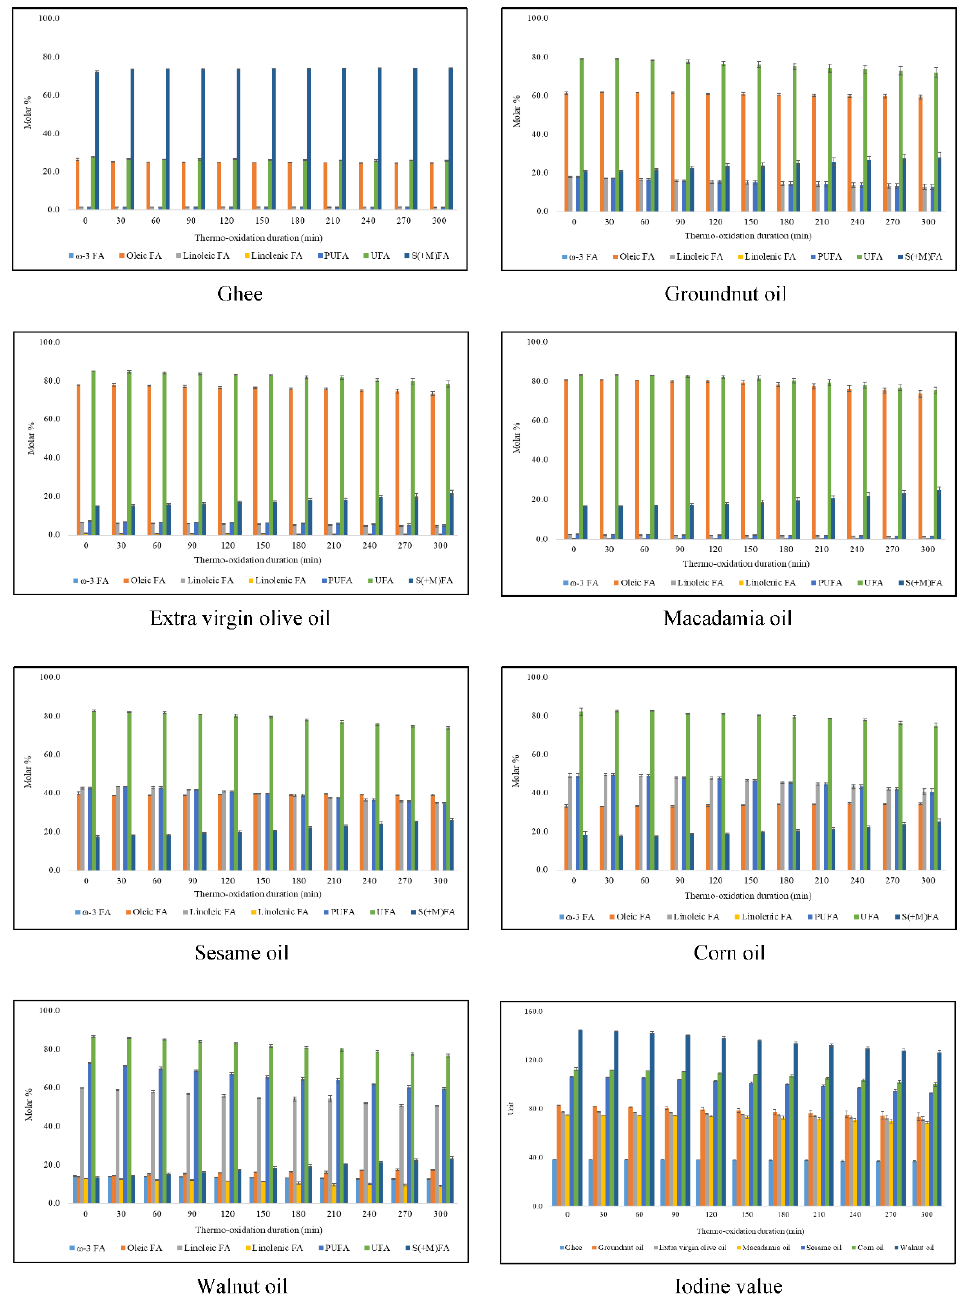
Figure 5. Changes in acyl groups and iodine values of thermally stressed culinary oils subjected to a continuous thermo-oxidation at 180 °C for 300 min. The values are presented as mean ± SD molar % (FA) and mean ± SD unit (IV) of oil.